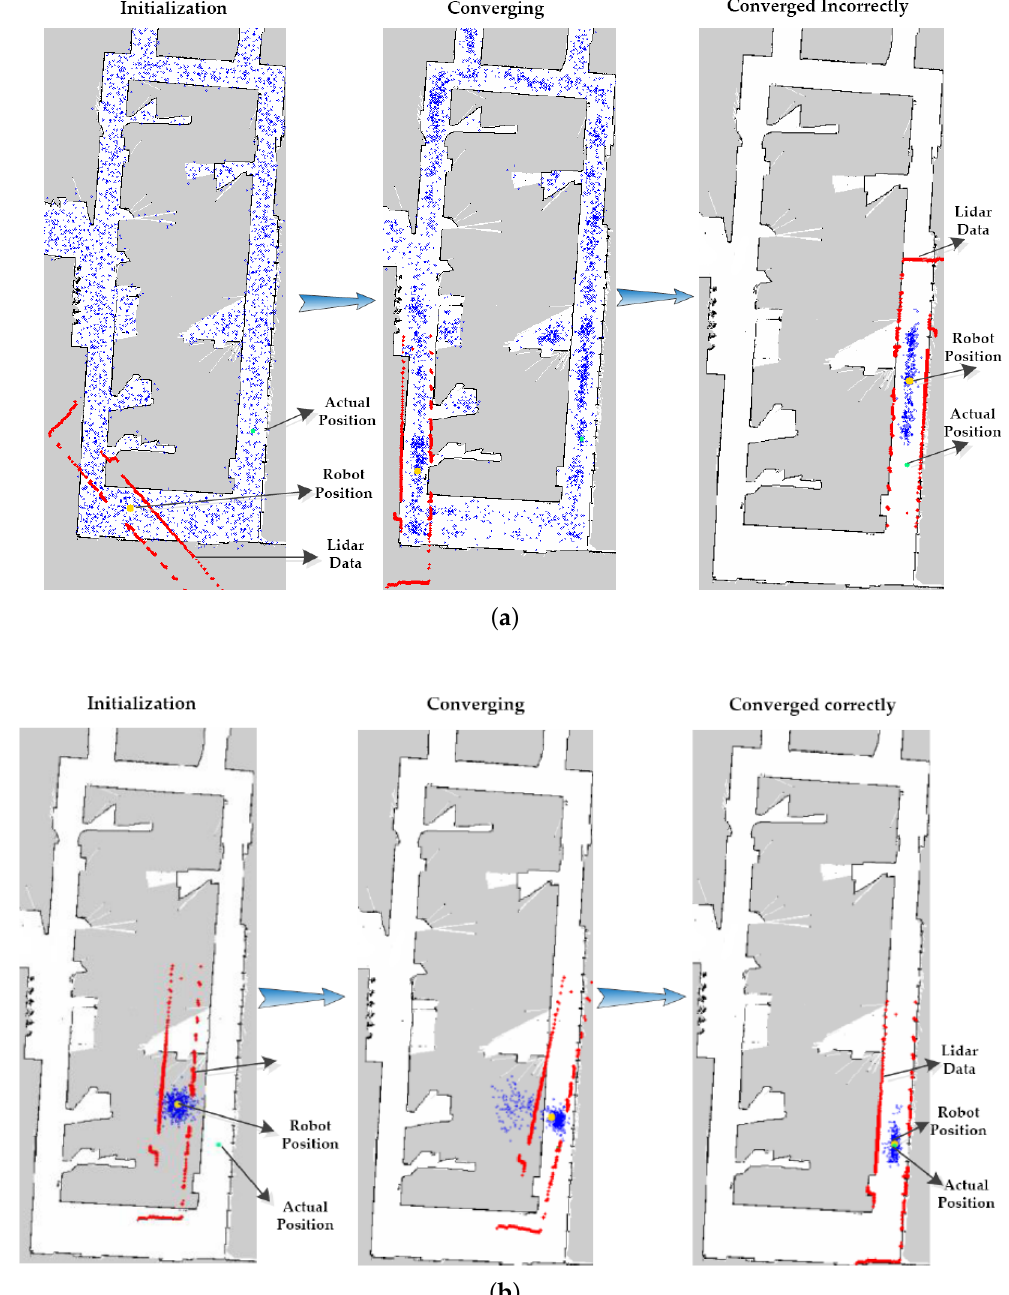
Figure 9. ( a ) The process of adaptive Monte Carlo localization (AMCL) with 10,000 particles was performed in a grid map with an area of 702 m 2 . Particles were initialized by a global uniform distribution method, and they then converged incorrectly. ( b ) The process of HPFL with 3000 particles in the same grid map of the actual scene. Particles finally converged successfully, and the robot got the right